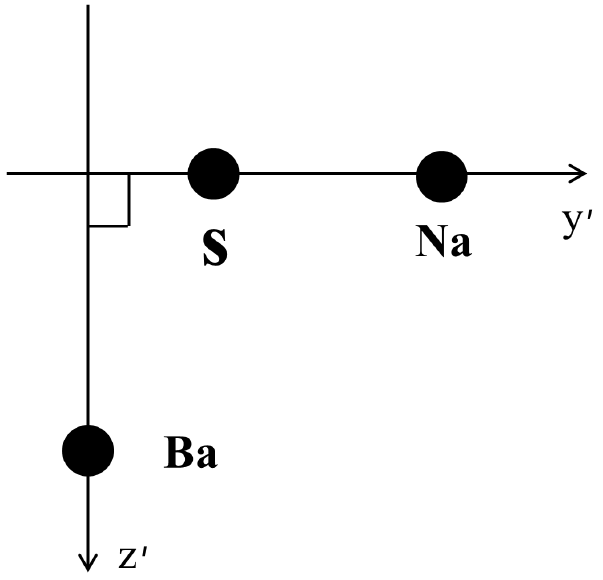
Figure 3. Reorientation axes. y and z´ are lines parallel to y and z axis respectively.